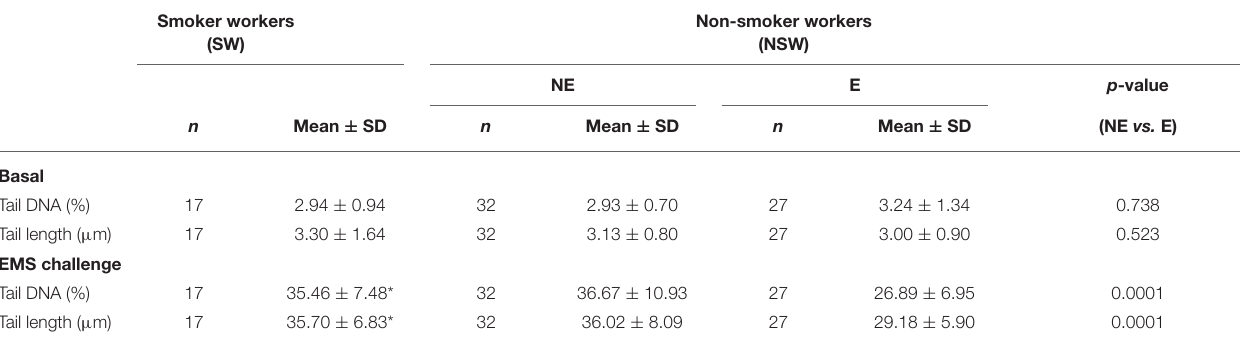
TABLE 3 | Results of the comet assay in leukocytes (basal) and of the comet-based challenge assay. Smoker workers (SW)